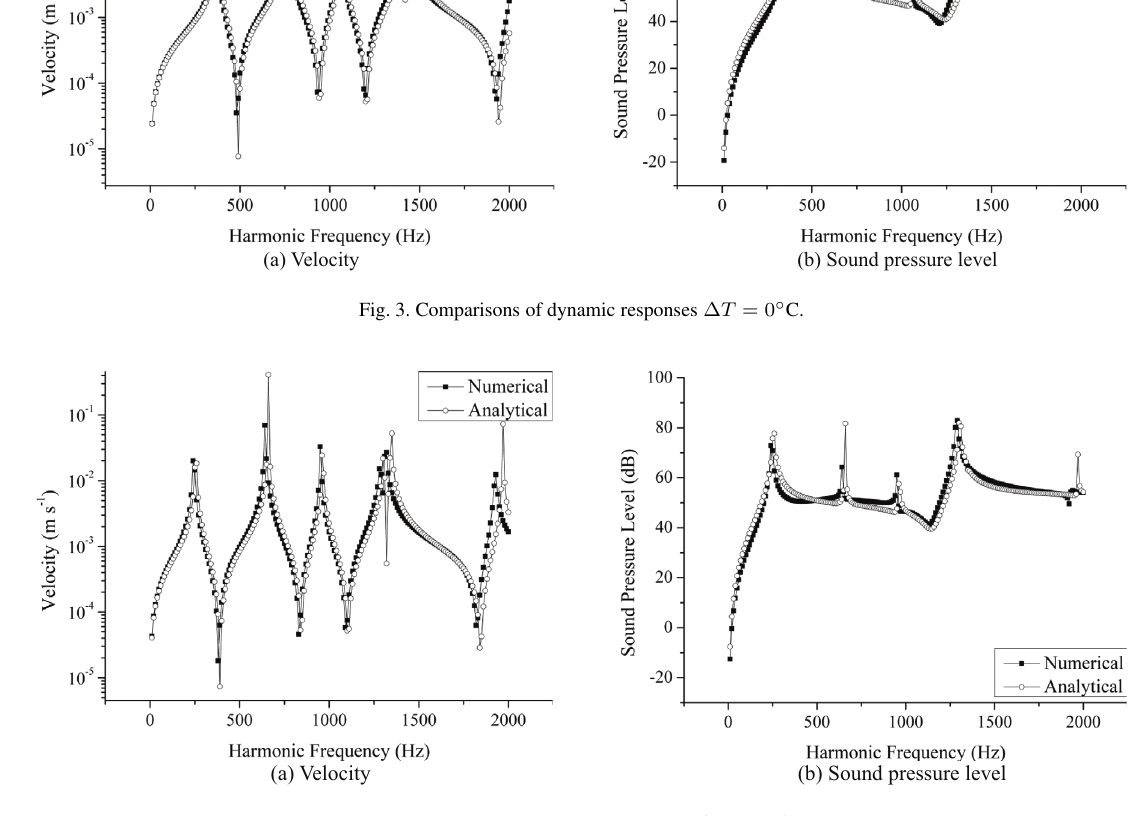
Fig. 4. Comparisons of dynamic responses Δ T = 50 ◦